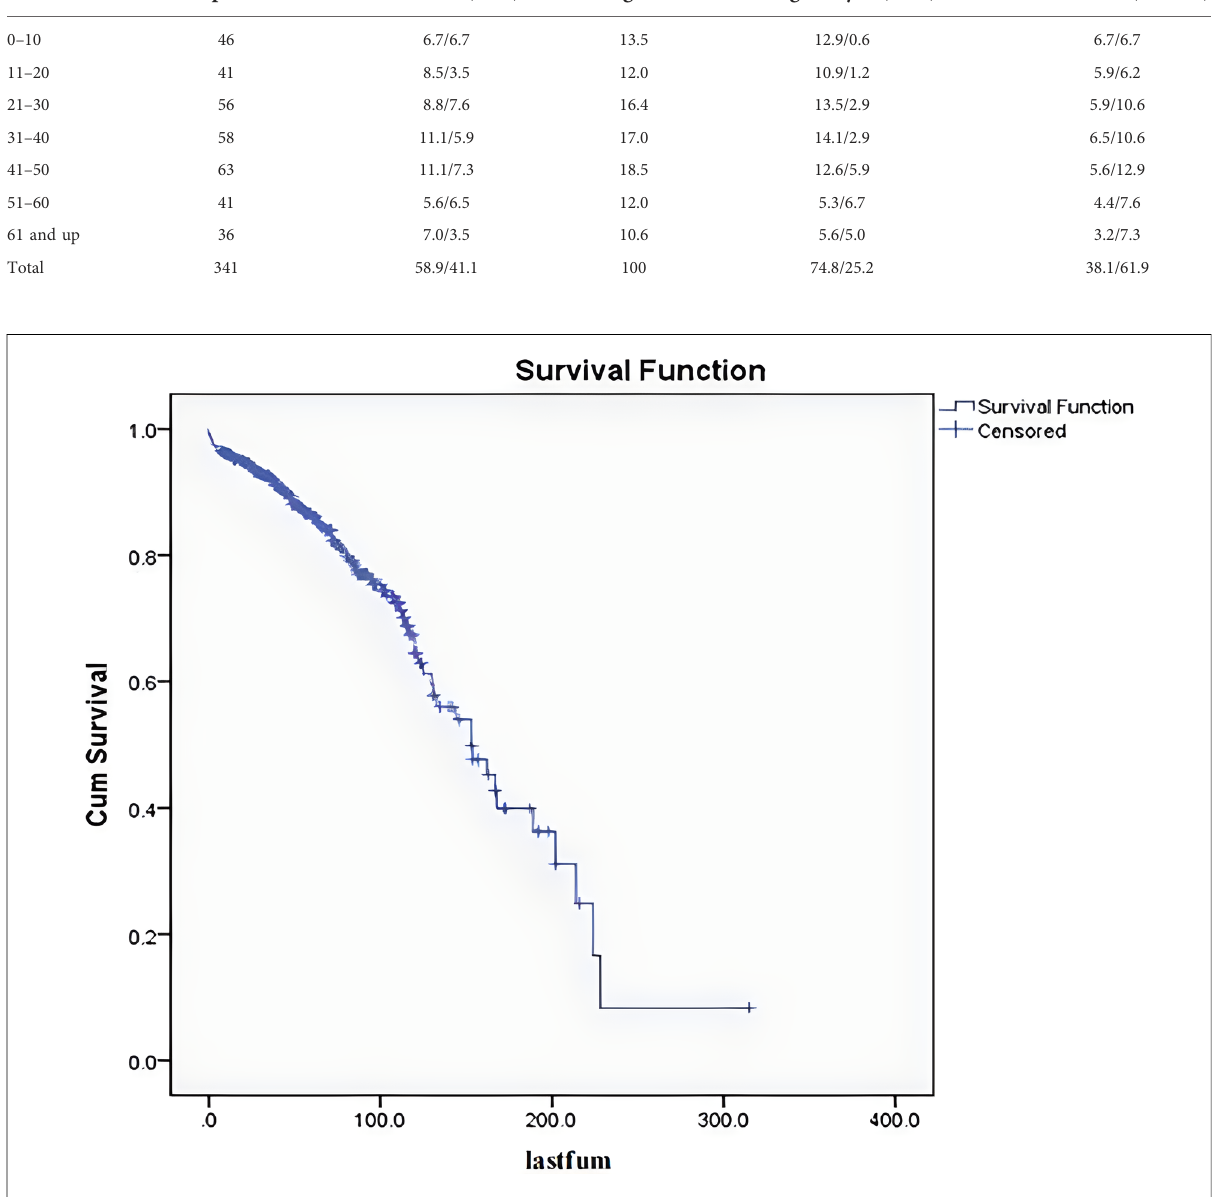
FIGURE 2 Overall survival curve for the 341